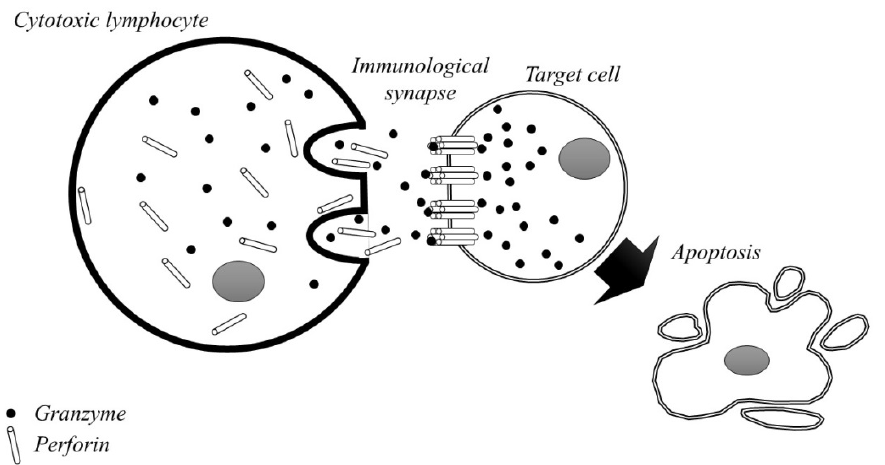
Figure 2. The formation of the granzyme/perforin immunological synapse.